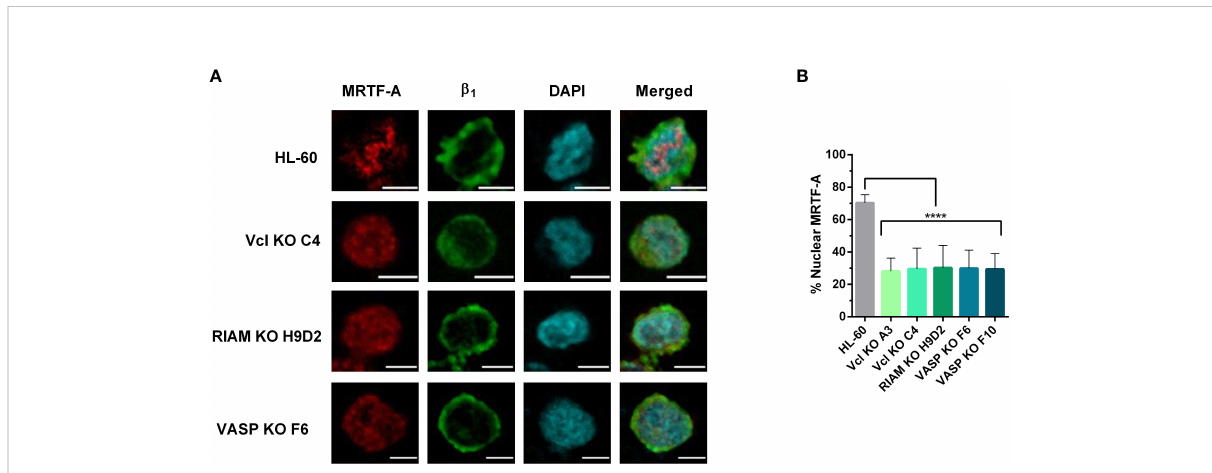
FIGURE 4 MRTF-A distribution is altered in Vinculin, RIAM and VASP knockouts. (A) HL-60 parental cells and the knockouts for Vinculin (Vcl), RIAM and VASP were differentiated into neutrophil-like cells, fi xed, permeabilized and fl uorescently labelled with an anti-MRTF-A mAb, DAPI for nuclear staining and anti- b 1 integrin to delimit the plasma membrane. Images show representative results from 3 independent experiments analyzed by confocal fl uorescence microscopy. Bars indicate 5 µm. (B) Quanti fi cation of MRFT-A nuclear distribution in these images is represented. Results are represented as relative to the wild-type nuclear ratio and are from 3 independent experiments with at least 50 cells. Data are presented as mean ± SD, where the error bars denote standard deviation. Signi fi cance (ANOVA) has been calculated with respect to HL-60 controls, **** denotes